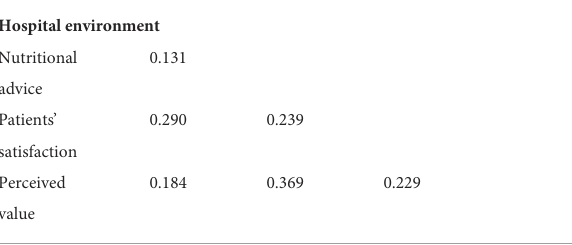
TABLE 2 Discriminant validity